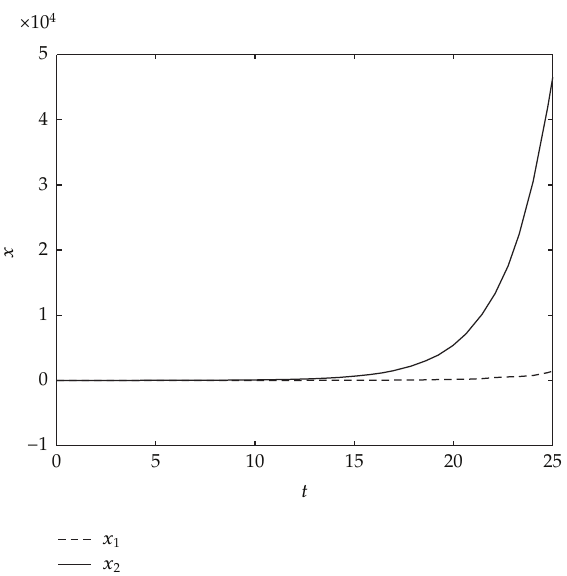
Figure 1: The trajectory of solution of system i (cid:8) 1.